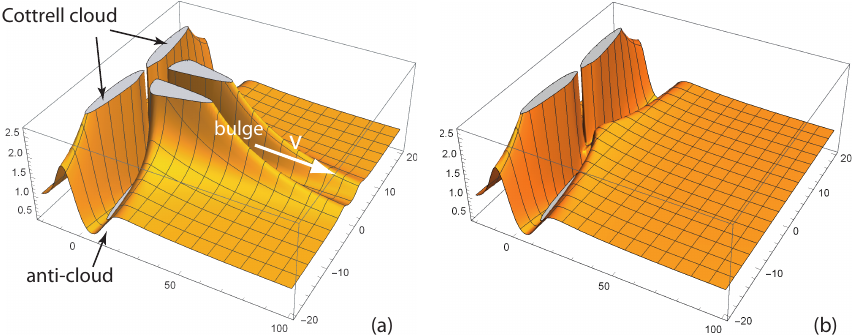
Figure 6. 3D plots of the dimensionless concentration field ¯ c ( x , z ) numerically calculated with the FEM when D ⊥ = 0 ( a ) and D ⊥ = D (cid:107) ( b ). In this simulation, the layers are compressed and v = 0.1 mm/s. In these plots, 1/ e < ¯ c < e , − 20 < ¯ x < 100 and − 20 < ¯ z < 20 (adapted from Ref. [28], with kind permission of the European Physical